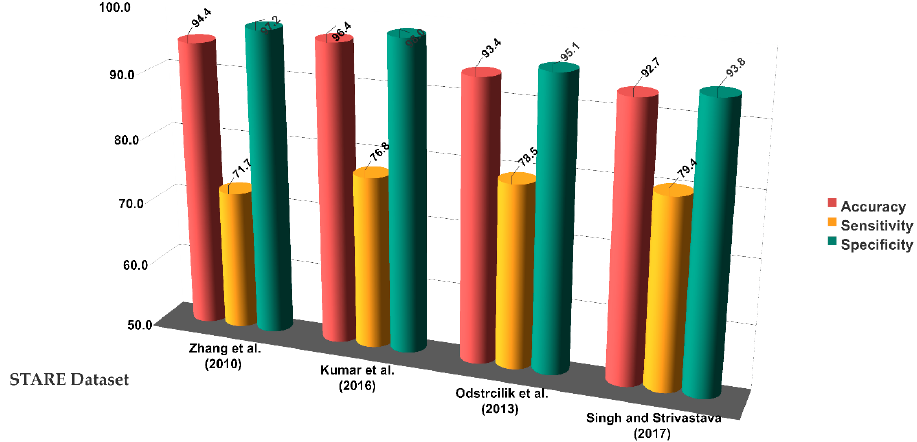
Figure 10. Summarized graphical comparison between some of kernel-based methods performance ( Accuracy , Sensitivity and Specificity ) based on STARE dataset.